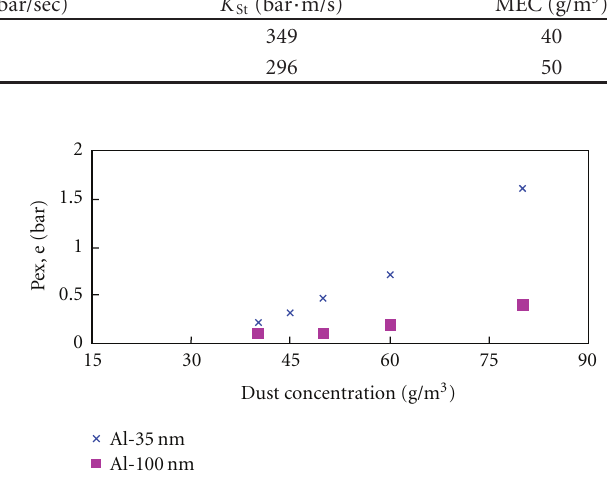
Figure 3: The P max for 35 nm Al ( × ) and 100nm Al (